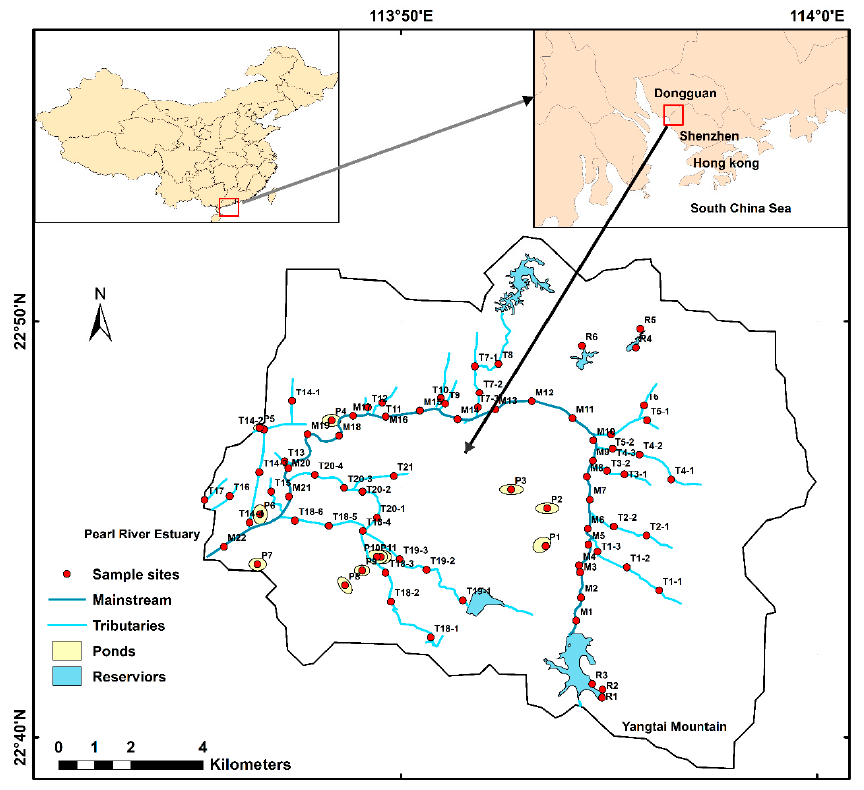
Figure 1. Sampling sites within the Maozhou River watershed in Shenzhen, China.